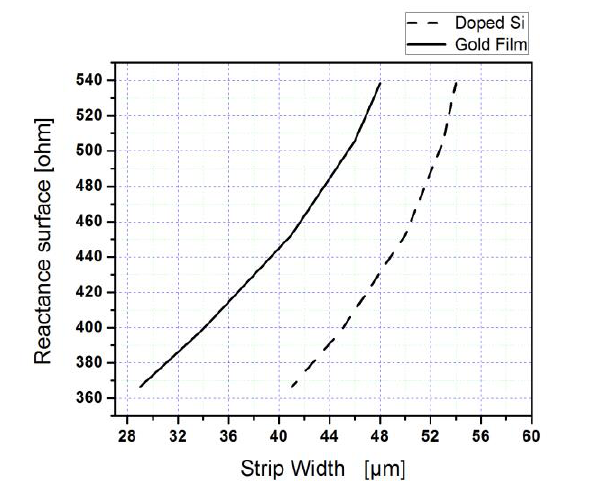
Figure 4: Equivalent surface reactance of a grounded silicon substrate of thickness 60 µm loaded by periodic strips of width W and periodic distance p = 94 µm.